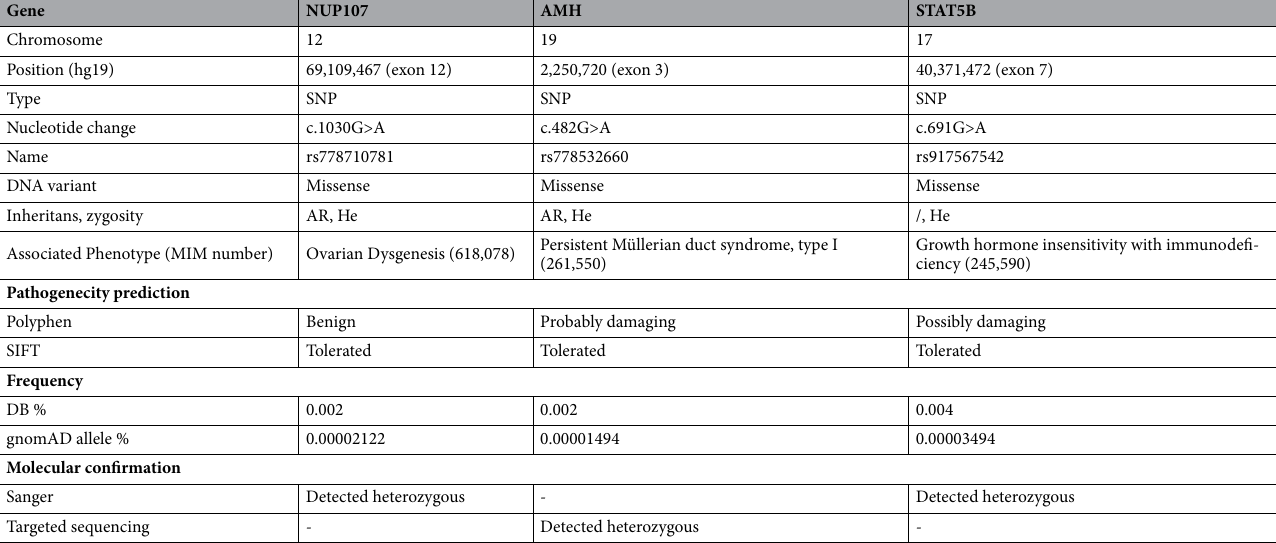
Table 1. Candidate variants from patient 2 whole genome sequencing. AD autosomal dominant, AMH anti-Müllerian hormone, AR autosomal recessive, Del deletion, He heterozygous, Ho homozygous, NUP107